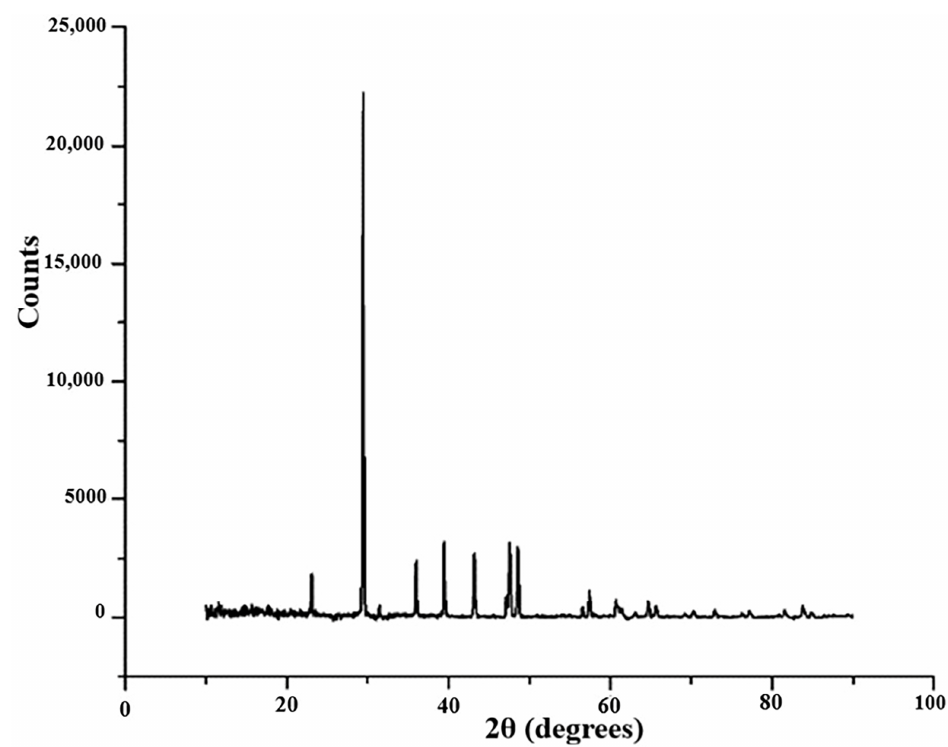
Figure 13. XRD analyses for the Extrudr BDP Flax material.